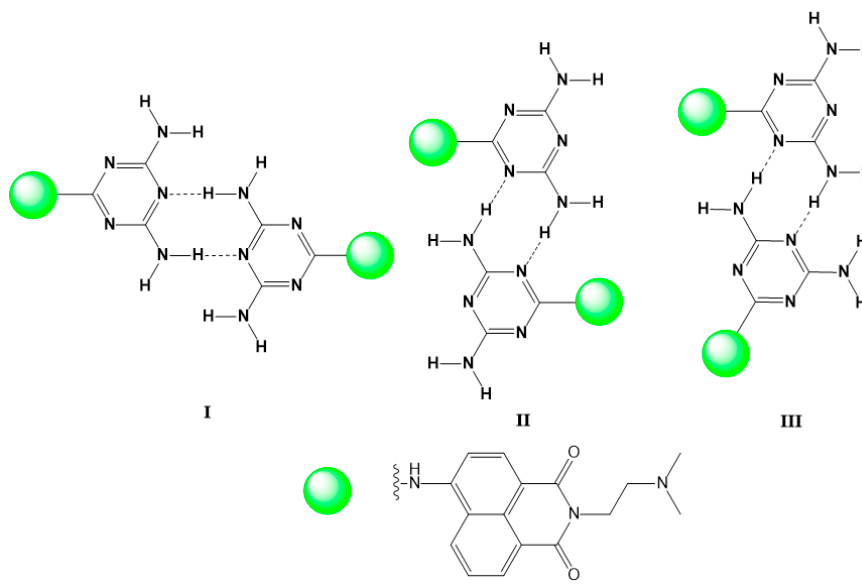
Figure 1. Hydrogen bonding motifs formed by self-assembling dimers of DAT